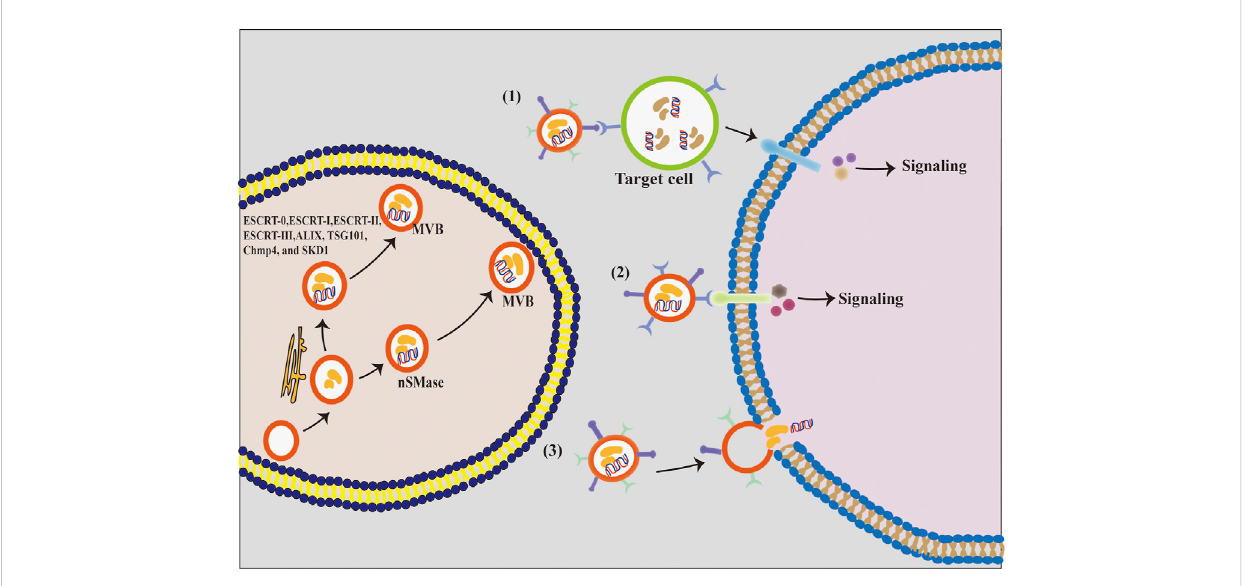
FIGURE 2 The formation process and theintercellular communication mode ofexosomes. (1) Exosomal membraneprotein fi rst binds to the cellular receptor, and then acts on its target cells and activates the intracellular signaling cascades. (2) Exosomal membrane proteins bind directly to the target cell ’ s receptors and activate their intracellular signaling pathways. (3) Exosomal membrane directly fuses with the phospholipid bilayer of the target cell, and exosomal components, including proteins, lipids, nucleic acids, and other substances, are released into the cytoplasm of the target cell in a non- selective